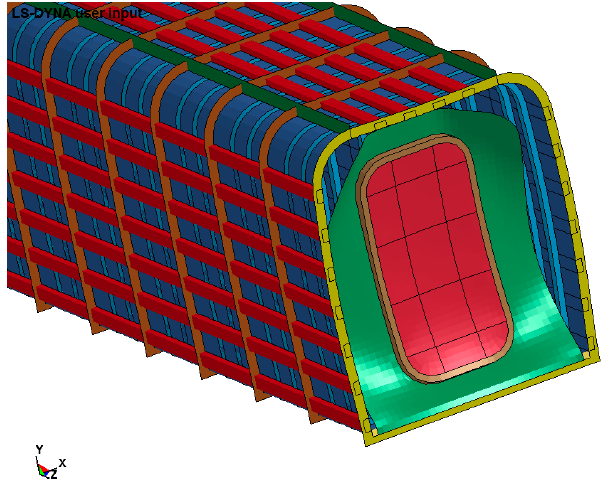
Figure 10. Process of the front door detaching from the bulkhead.